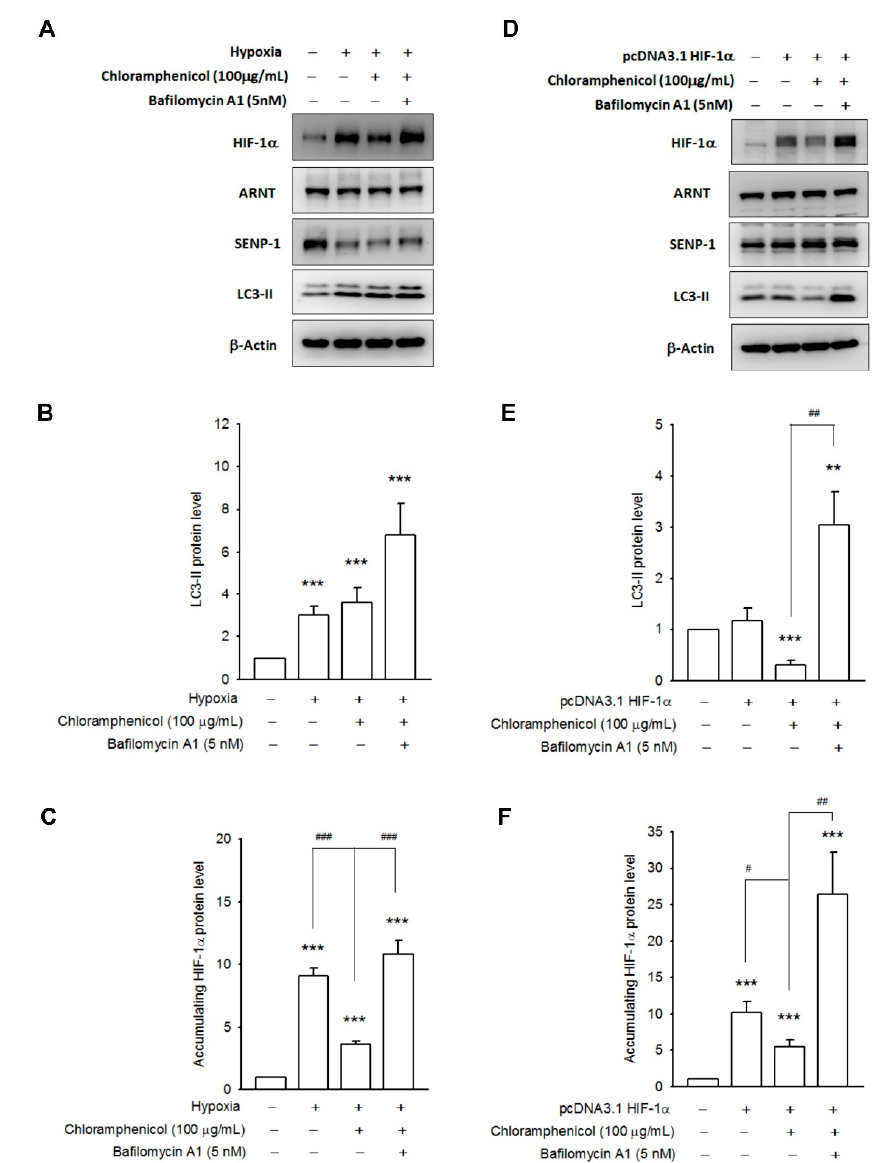
Figure 5. Chloramphenicol potentiated HIF-1 α protein degradation via the autophagy pathway. Representative images showing the inhibition of autophagic flux by bafilomycin A1 (5 nM), and the amelioration of chloramphenicol-mediated HIF-1 α degradation in hypoxia-conditioned A549 cells ( A ) or in HIF-1 α -overexpressing H1299 cells ( D ). Quantitative results of multiple experiments are shown for ( B , E ) LC3-II, and ( C , F ) HIF-1 α . (*** p < 0.001 indicates statistically significant difference from the control group; # p < 0.01, ## p < 0.01 and ### p < 0.001 indicates statistically significant difference from the chloramphenicol-treated control). N = 4 (A549 and H1299).